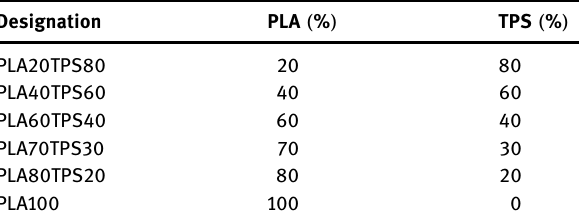
Table 2: Various composition of PLA/TPS blend bionanocomposites